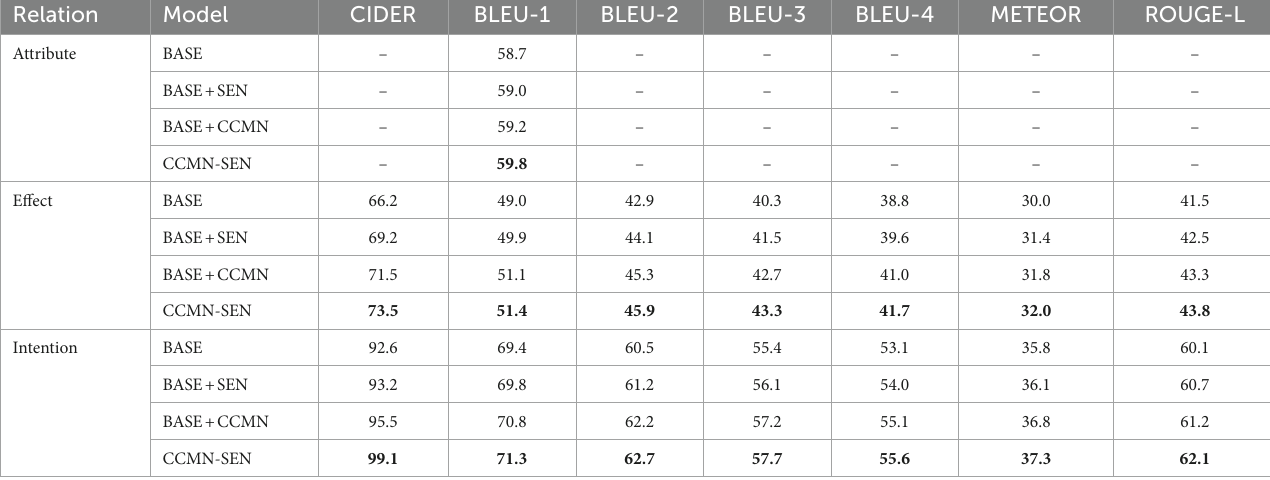
TABLE 2 Ablation study of CCMN-SEN model performance on the completion